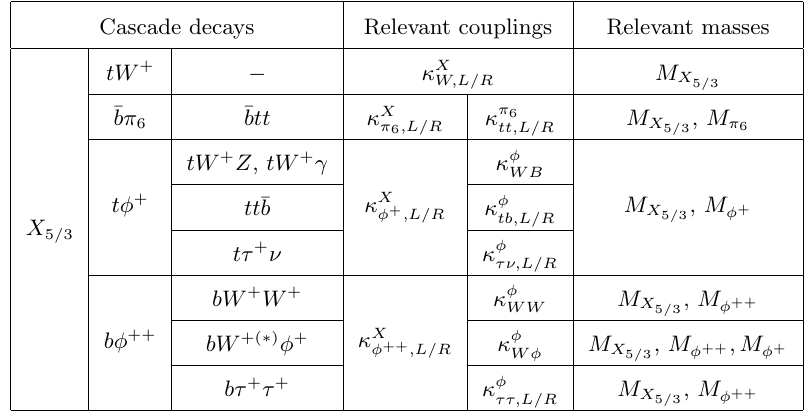
Table 2 . Decay channels of X